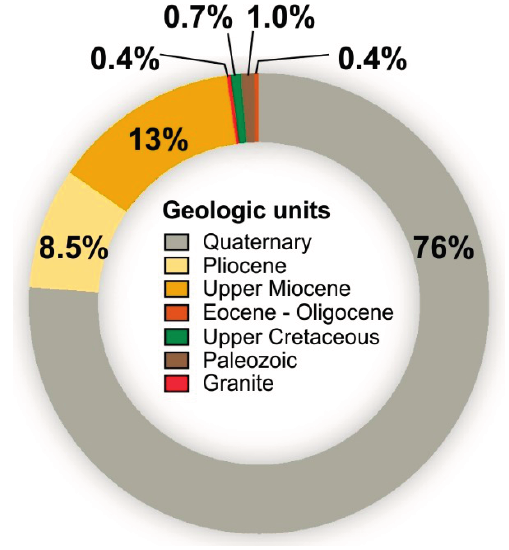
Figure 6. Correlation between urban deformations and geology in Istanbul. Percent values of subsiding SAR pixels for each geologic units are